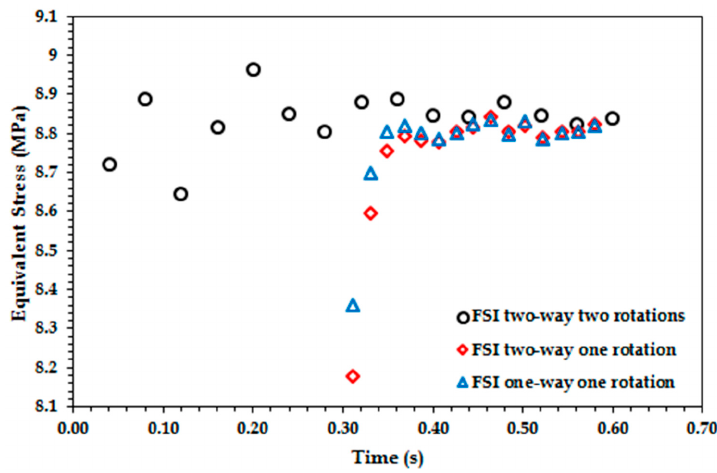
Figure 4. Prediction of equivalent stress from the three FSI simulations.